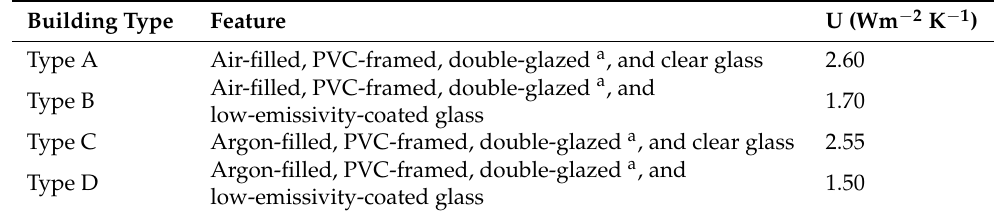
Table 4. Selected window types.